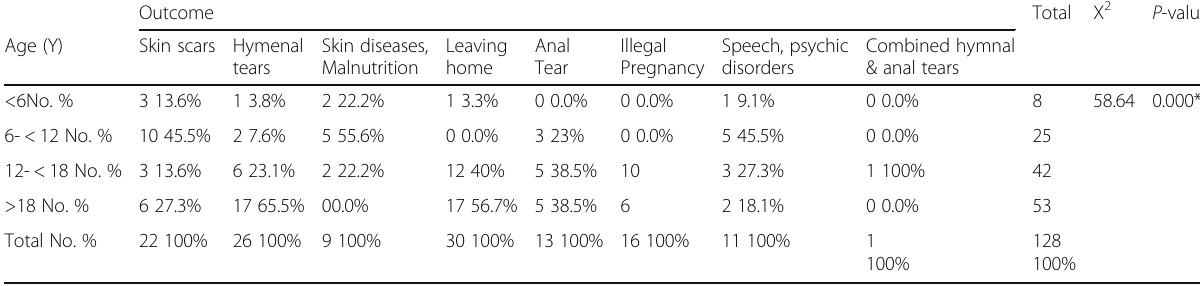
Table 6 Relation between age group and outcome among the studied cases Outcome Total X 2 P -value Age (Y) Skin scars Hymenal Skin diseases, Leaving Anal Illegal Speech, psychic Combined hymnal tears Malnutrition home Tear Pregnancy disorders & anal tears <6No. %